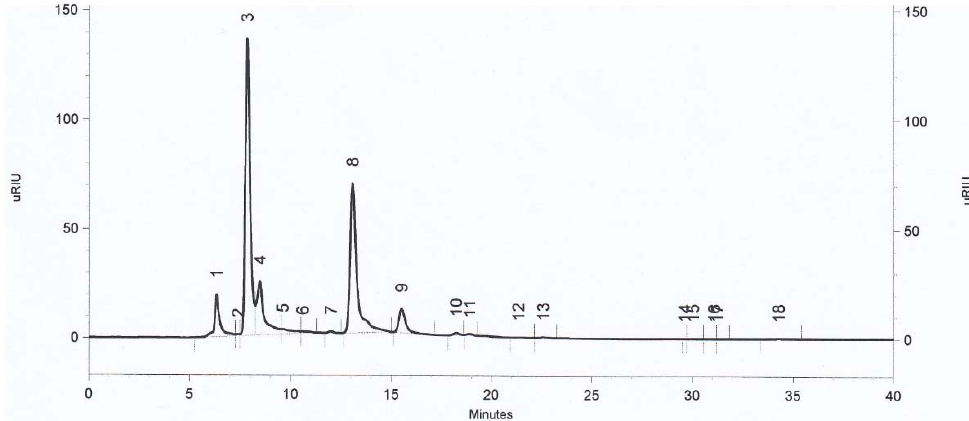
Figure 7. RI chromatogram of investigated by ‐ products of the L. plantarum KB2 LAB 03 cultured on A100 M100 acid whey ‐ based medium. 8 ‐ lactic acid; 9 ‐ acetic acid; 10 ‐ propionic acid; 13 ‐ ethanol; 15 ‐ valeric acid.